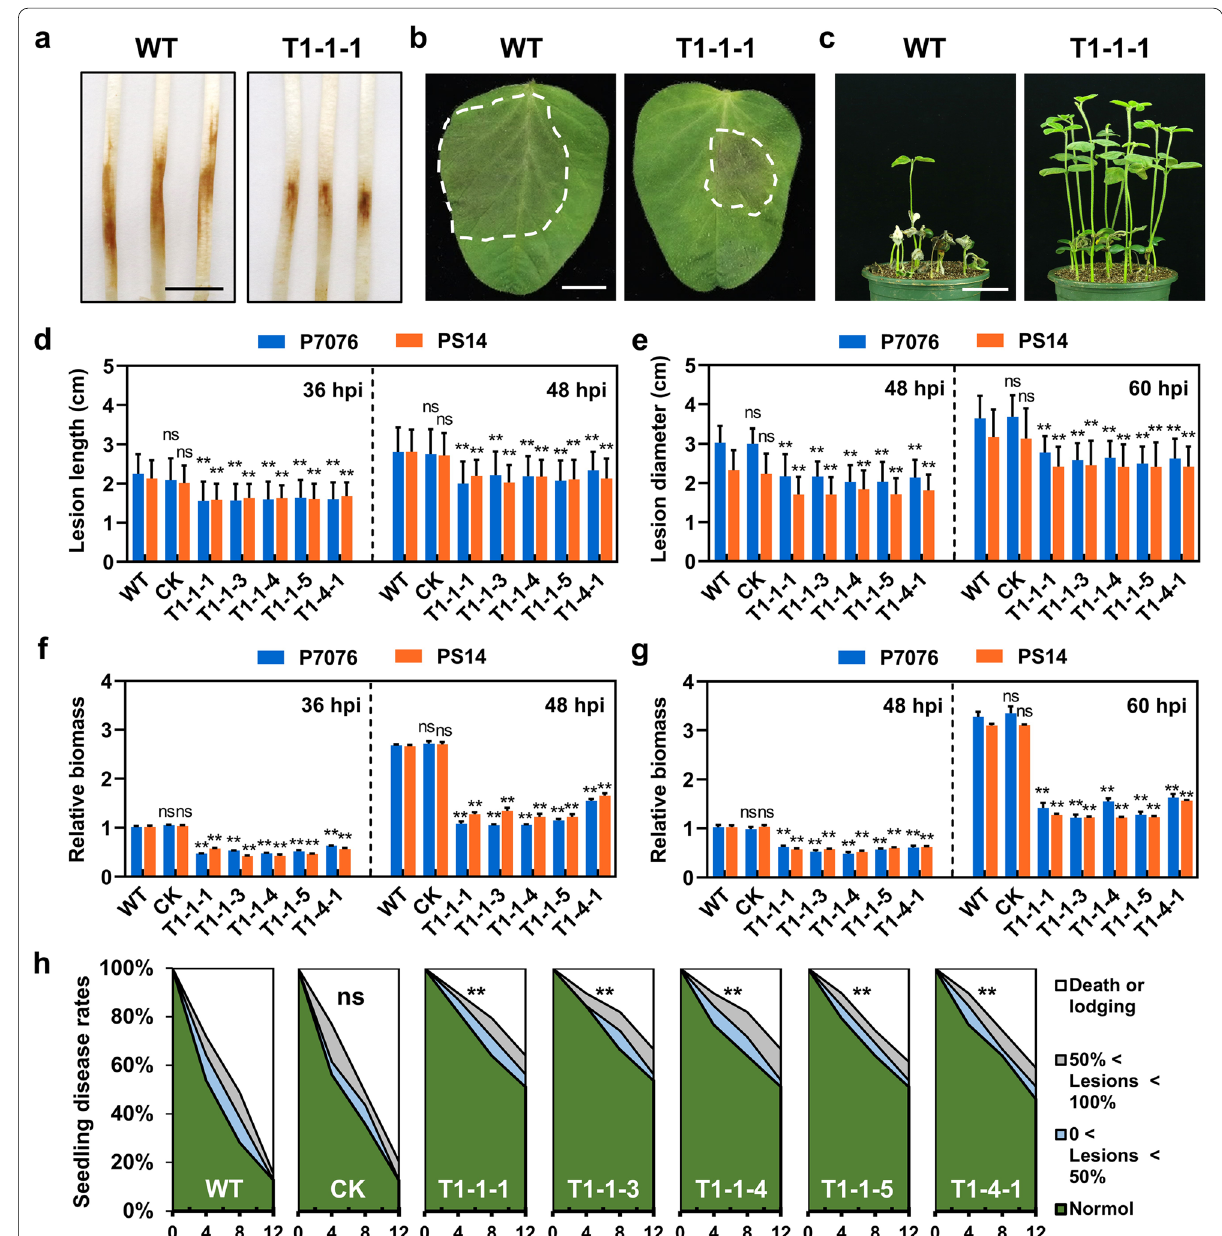
Fig. 5 GmPAO significantly enhances resistance against P. sojae in the transgenic soybean lines. The soybean lines were the same as in Fig. 1. Two P. sojae isolates (P7076 and PS14) that are virulent on WT were used. a , b Representative disease phenotypes at 36 hpi ( a ) and 60 hpi ( b ). Hypocotyls or unifoliate leaves were inoculated with P. sojae P7076. Scale bars, 1 cm. c Representative disease phenotypes of seedlings at 12 dpi. The seedlings were inoculated with P. sojae P7076 (5 10 4 zoospores/mL) using the root-dipping inoculation method. Scale bar, 5 cm. d , e Comparisons of the × hypocotyl lesion lengths and leaf lesion diameters caused by P. sojae P7076 or P. sojae PS14. Error bar represents mean SD, n 12, n represents ± ≥ sample number. f , g Quantitation of resistance levels via assessment of P. sojae biomass accumulations in inoculated hypocotyls and leaves by genomic qPCR. Error bar represents mean SD, n 3, n represents sample number. h Seedling disease ratings in the transgenic lines over time. ± = The disease symptoms were recorded at 4, 8, and 12 dpi. Disease ratings are shown with different colors (n 12, n represents sample number). ≥ All the experiments were performed three times (biological replicates) with similar results. The data in d – h were analyzed by Shapiro–Wilk test to determine the Normality and Lognormality Tests across groups, and then analyzed by one-way ANOVA with post-hoc Dunnett’s multiple comparisons test for groups that had passed the normality test (ns, no significant difference; ** P < 0.01). The exact n, SD values, and P values are shown in the